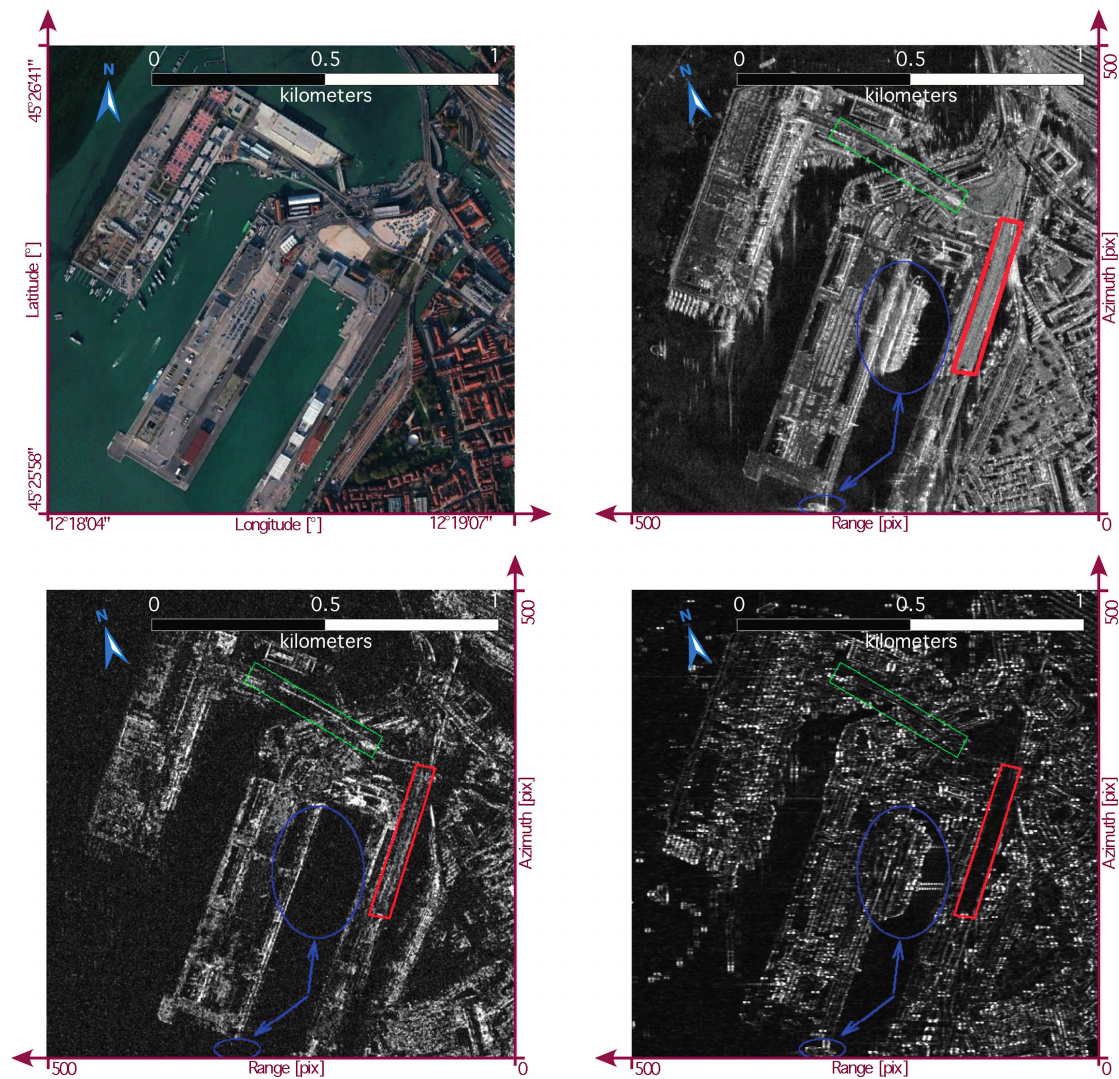
Figure 9. The maps are in SAR geometry and cover the area sketched in the Google Earth optical image in ( A ) the inset. ( B ) Intensity, ( C ) temporal and ( D ) spectral coherence of the harbor docks of